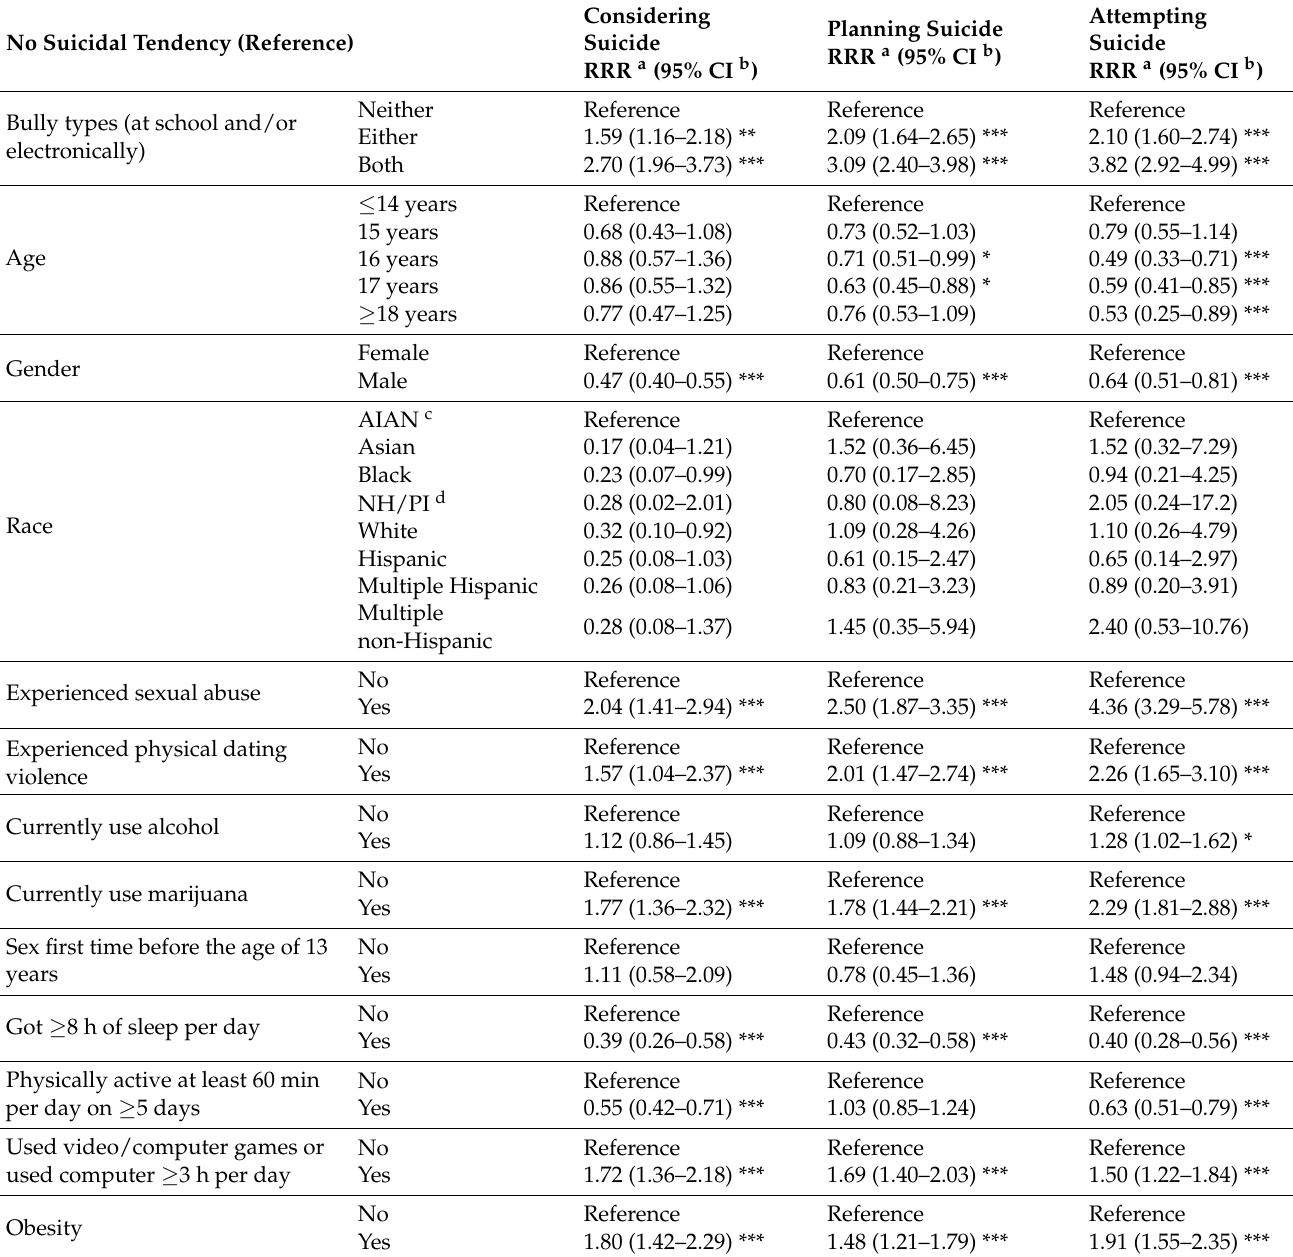
Table 5. Adjusted multinomial logistic regression of the number of bully types with suicidal